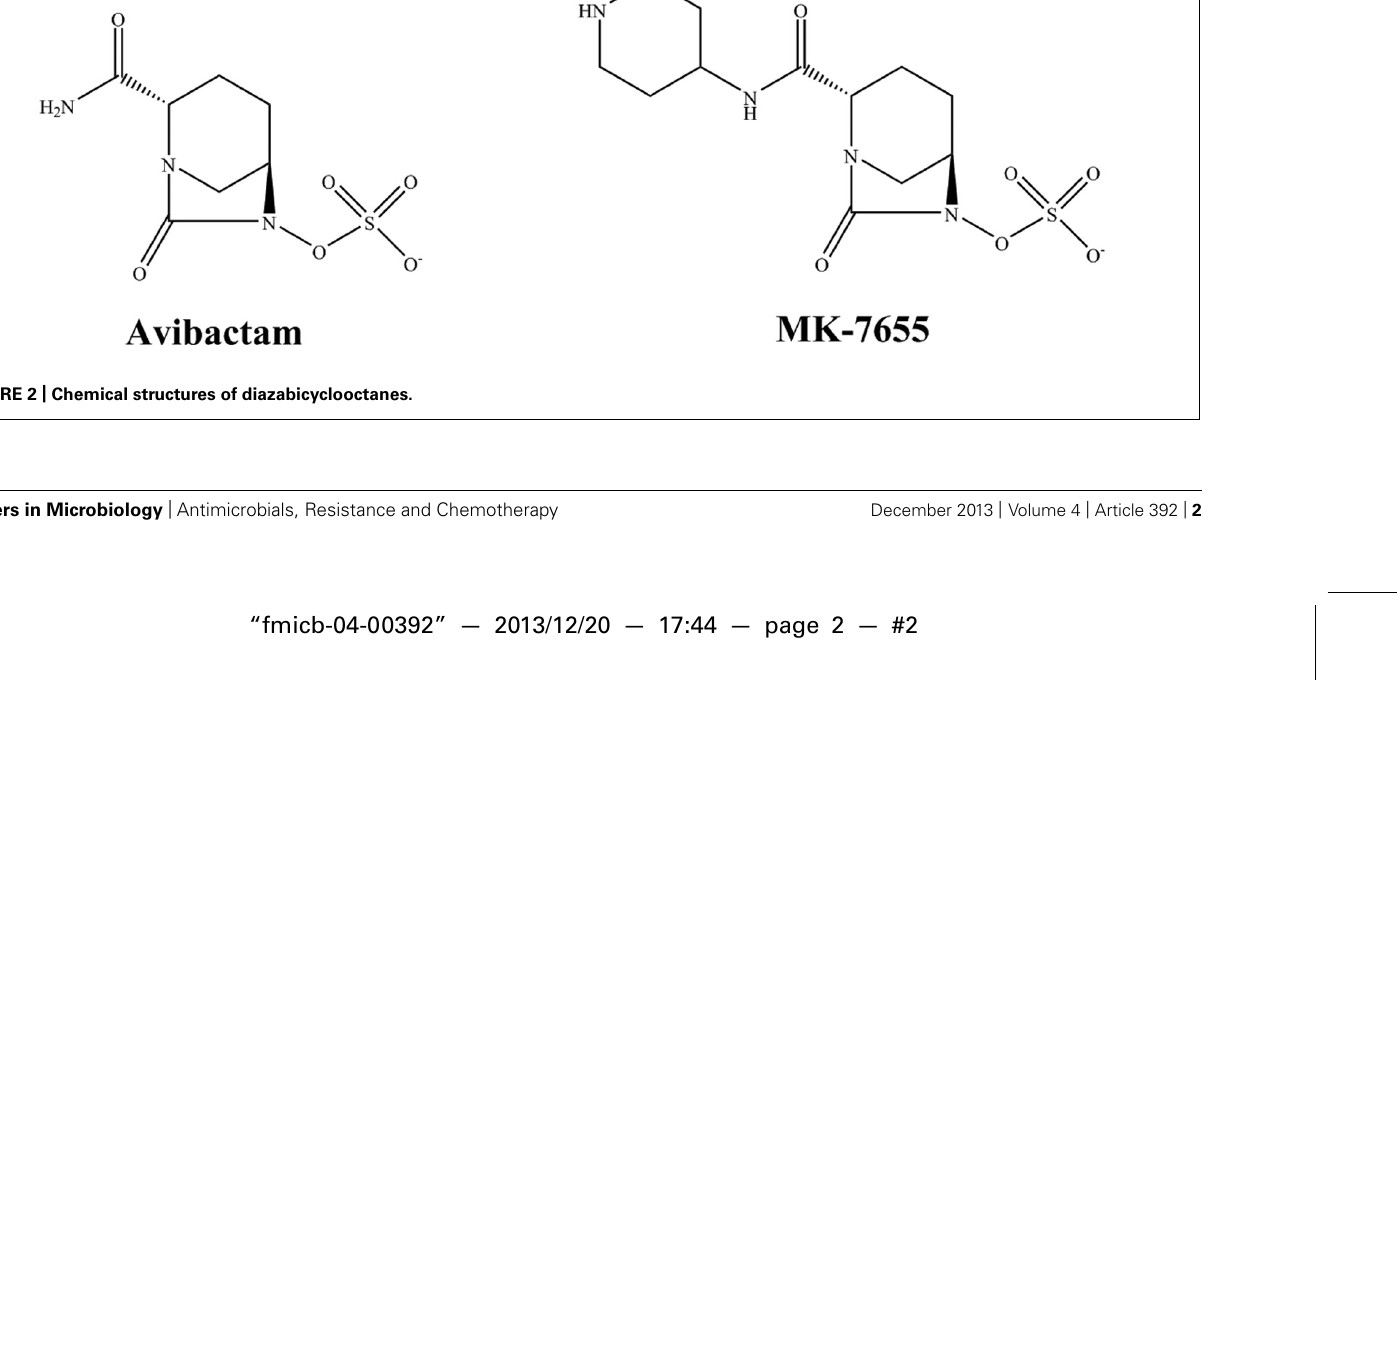
( Figure2 ). Asa β -lactamaseinhibitor,AVIinactivates β -lactamsby a reversible fast acylation and relatively slow deacylation reaction.